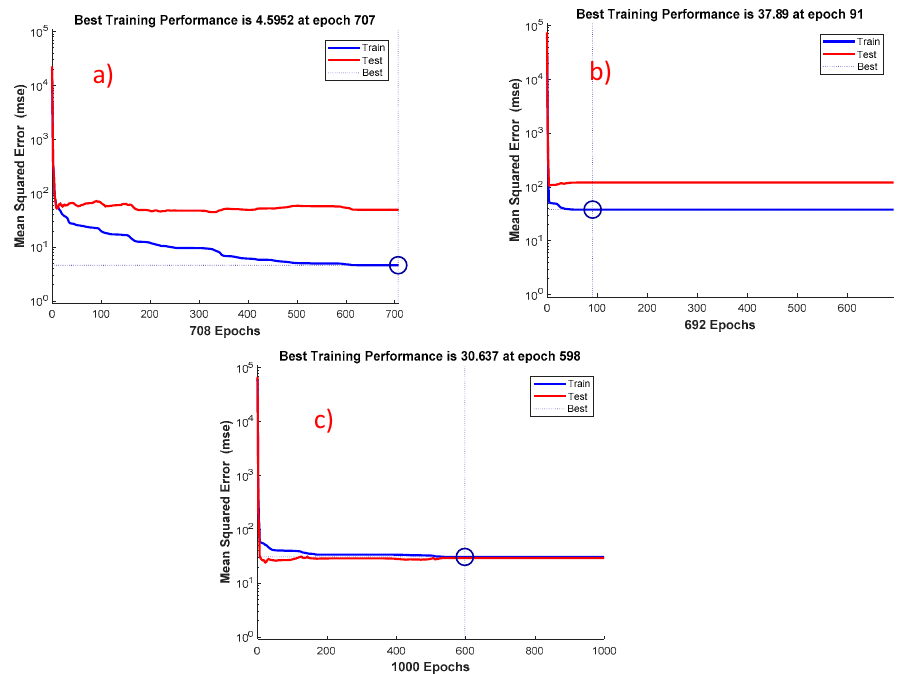
Figure 5. Comparison of the MSE for different techniques: ( a ) With all features; ( b ) CFS feature selection technique; ( c ) ReliefF feature selection technique for training and validation.